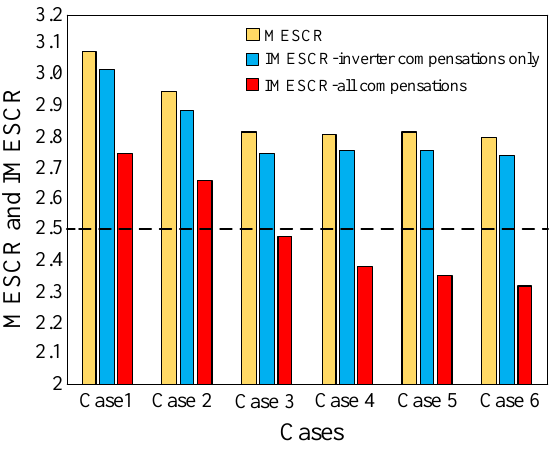
Figure 8. Comparison between the MESCR and IMESCR in the Eastern China Grid.